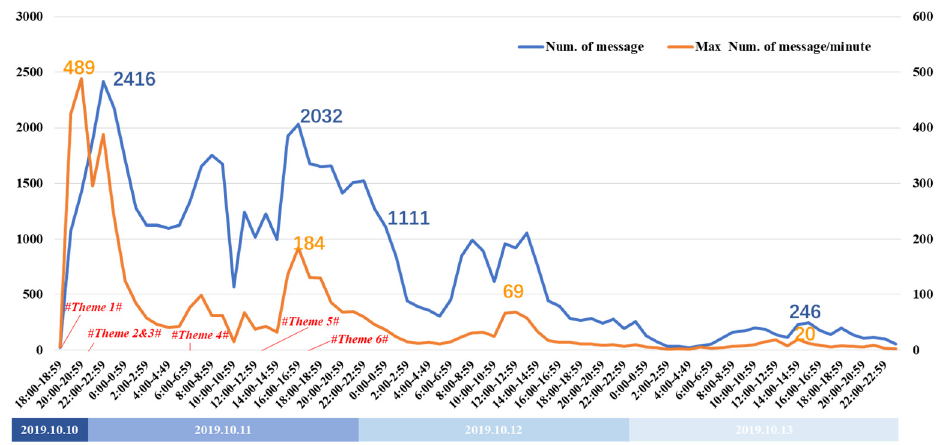
Figure 4. Trends for the number of messages and the maximum number of messages per minute.